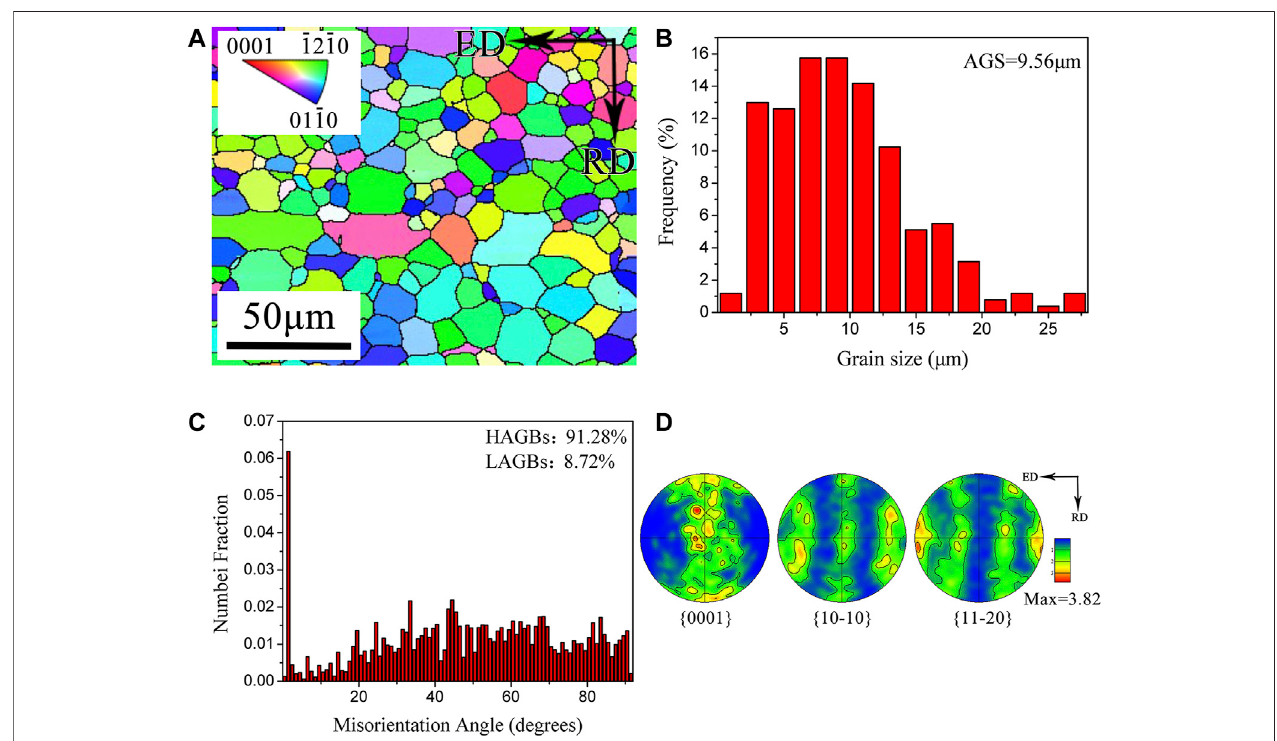
FIGURE 5 | Microstructure and texture of the LAY410 alloy: (A) inverse pole fi gure, (B) grain size map, (C) misorientation angle distribution histogram, (D) pole fi gures.